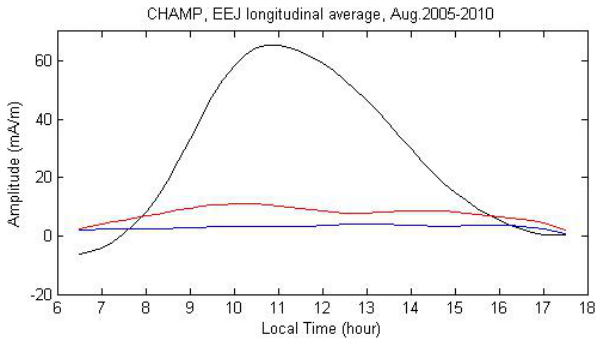
557 7. The same as Fig. 2, but for the solar minimum years Aug. 2005-2010. 558 Fig. same as Fig. 2, but for the solar minimum years Aug. 2005-2010. 558 Fig. 7. The Fig. 7. The same as Fig. 2, but for the solar minimum years Au- gust 2005–2010.